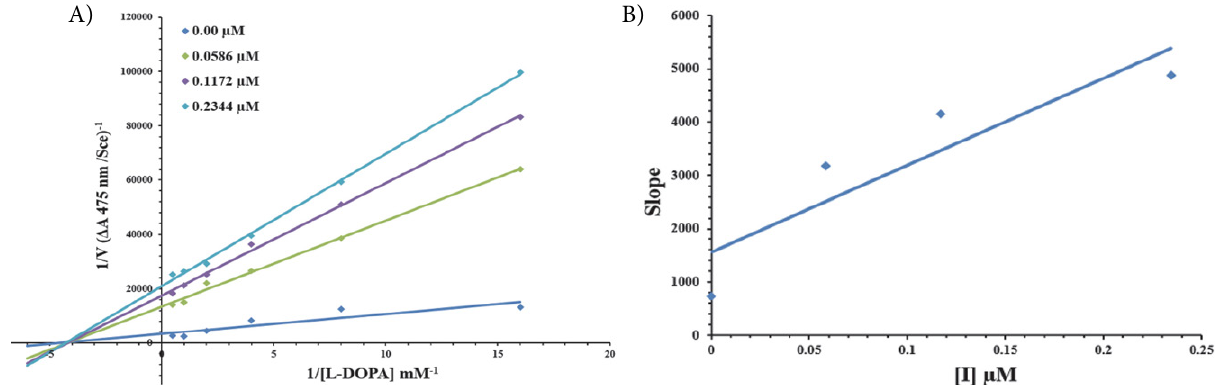
Figure 4. Lineweaver–Burk plots for inhibition of tyrosinase in the presence of compound 5. (a) Concentrations of 5 were 0.00, 0.0586, 0.1172 and 0.2344 µM, respectively. Substrate L-DOPA concentrations were between 0.0625 and 2 mM, respectively. (b) The inset represents the plot of the slope versus inhibitor 5 concentrations to determine inhibition constant. The lines were drawn using linear least squares fit.